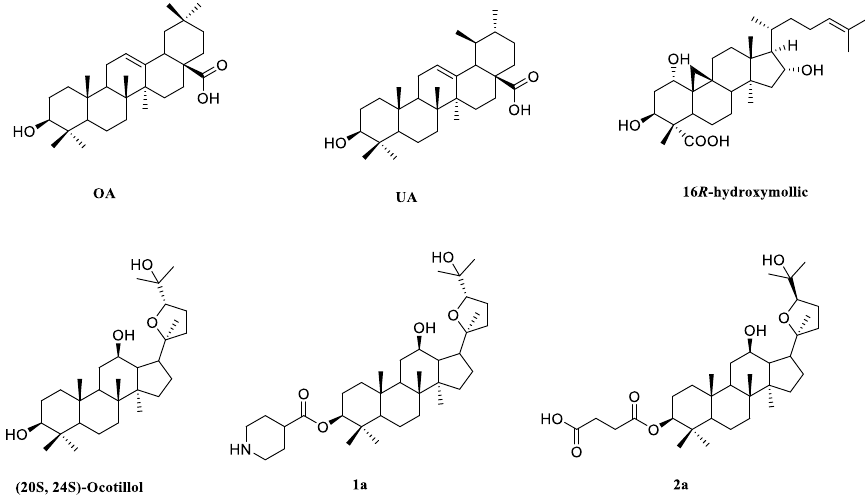
Figure 2. Structures of OA, UA, 16 R -hydroxymollic, (20 S , 24 S )-ocotillol, compounds 1a and 2a .